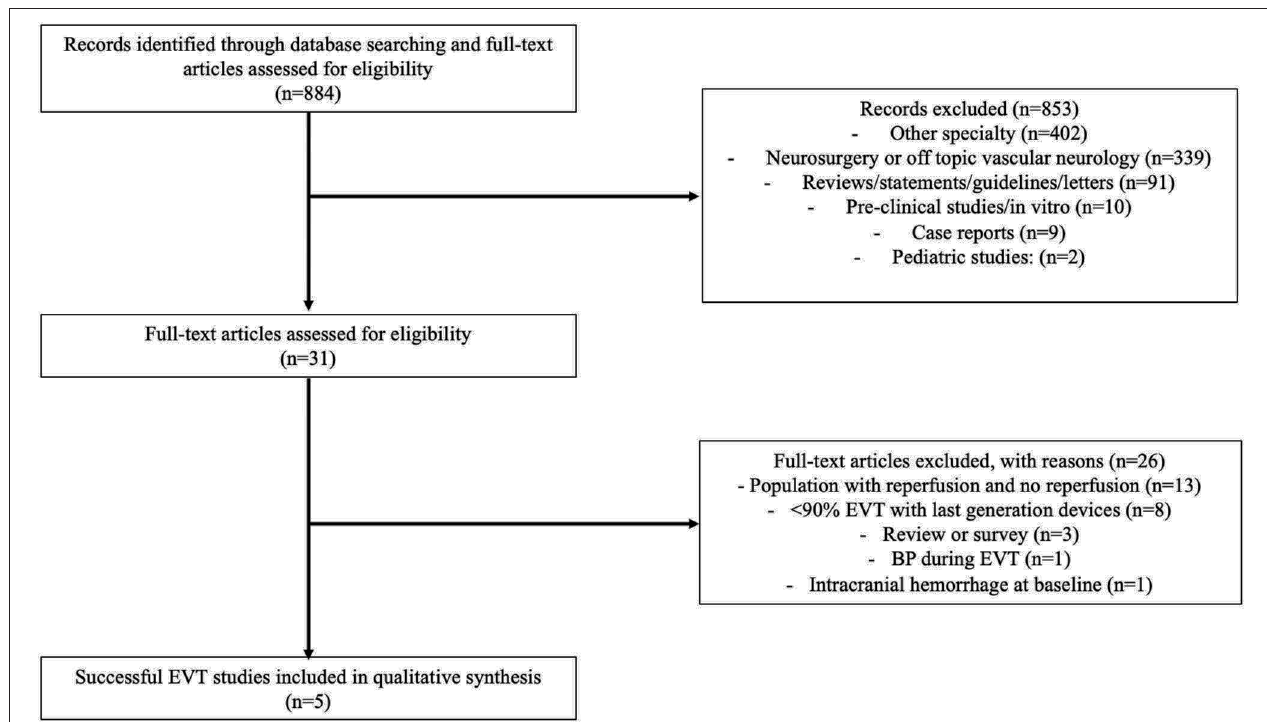
FIGURE 1 | Flow chart presenting the research database, the screening process and the number of included studies with reasons of